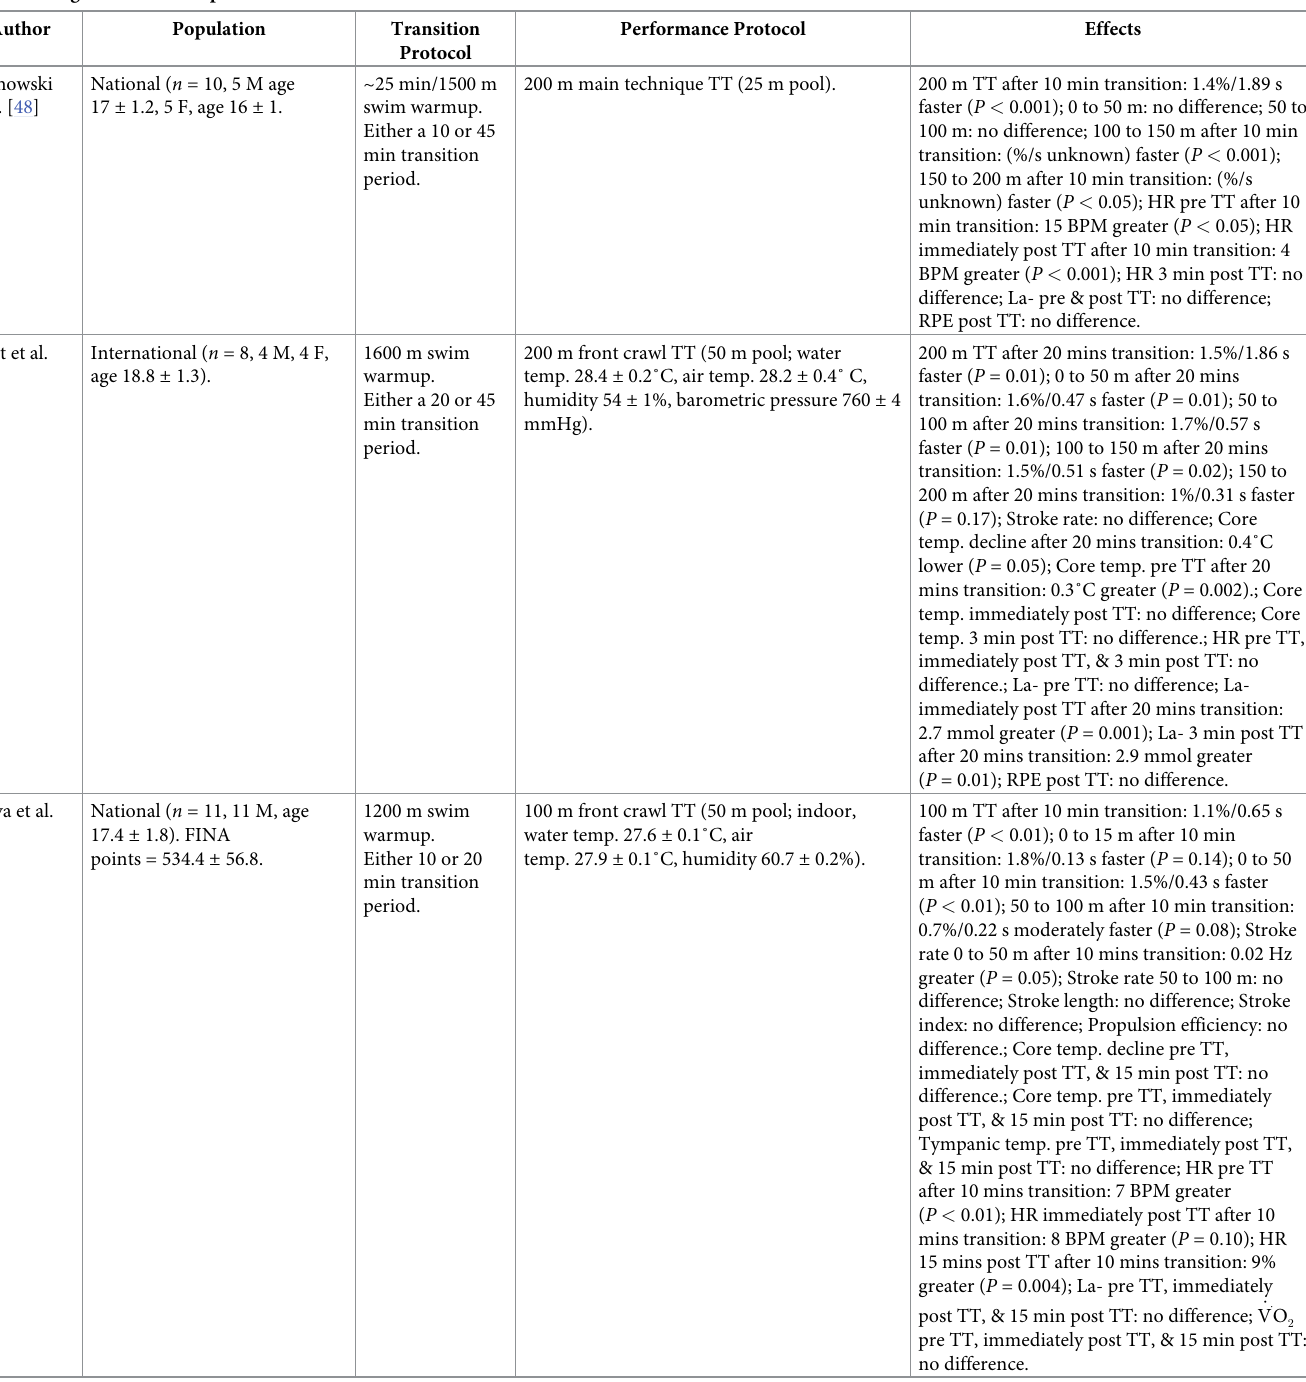
Table 2. Length of transition